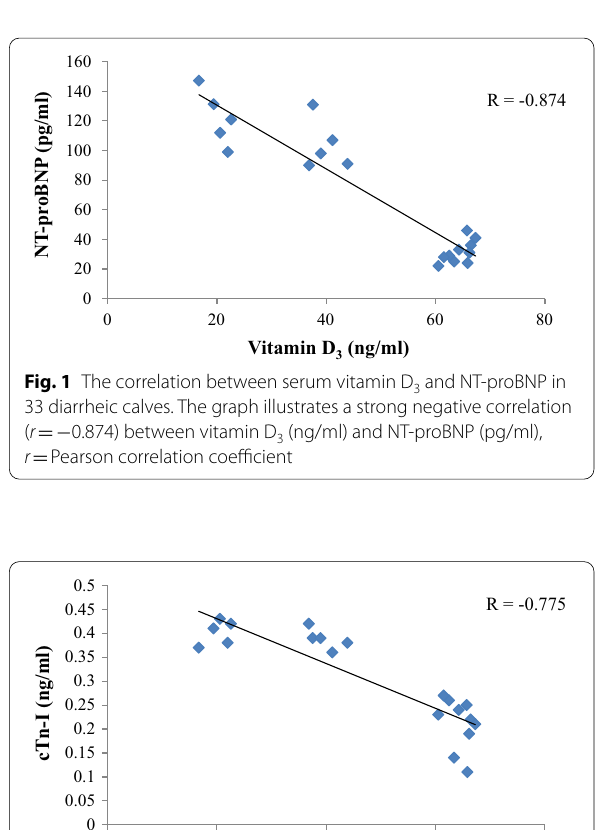
Fig. 2 The correlation between serum vitamin D 3 and cTn‑I in 33 diarrheic calves. The graph illustrates a strong negative correlation ( r 0.775) between vitamin D 3 (ng/ml) and cTn‑I (ng/ml), = − r Pearson correlation coefficient =